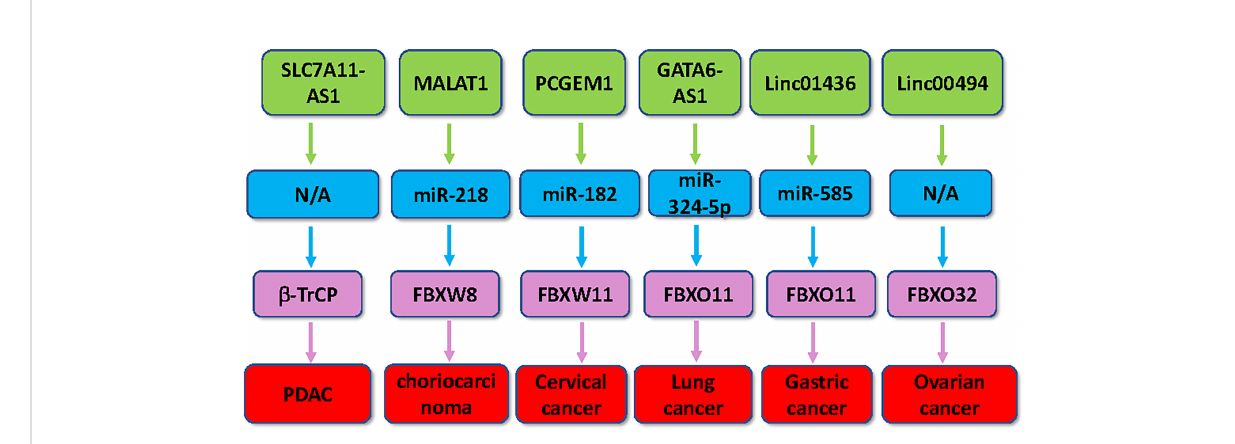
FIGURE 2 Multiple lncRNAs regulate the expression of F-box proteins in human cancer. Multiple lncRNAs, including SLC7A11-AS1, MALAT1, PCGEM1, linc01436, linc00494 and GATA6-AS1, regulate the expression of several F-box proteins in